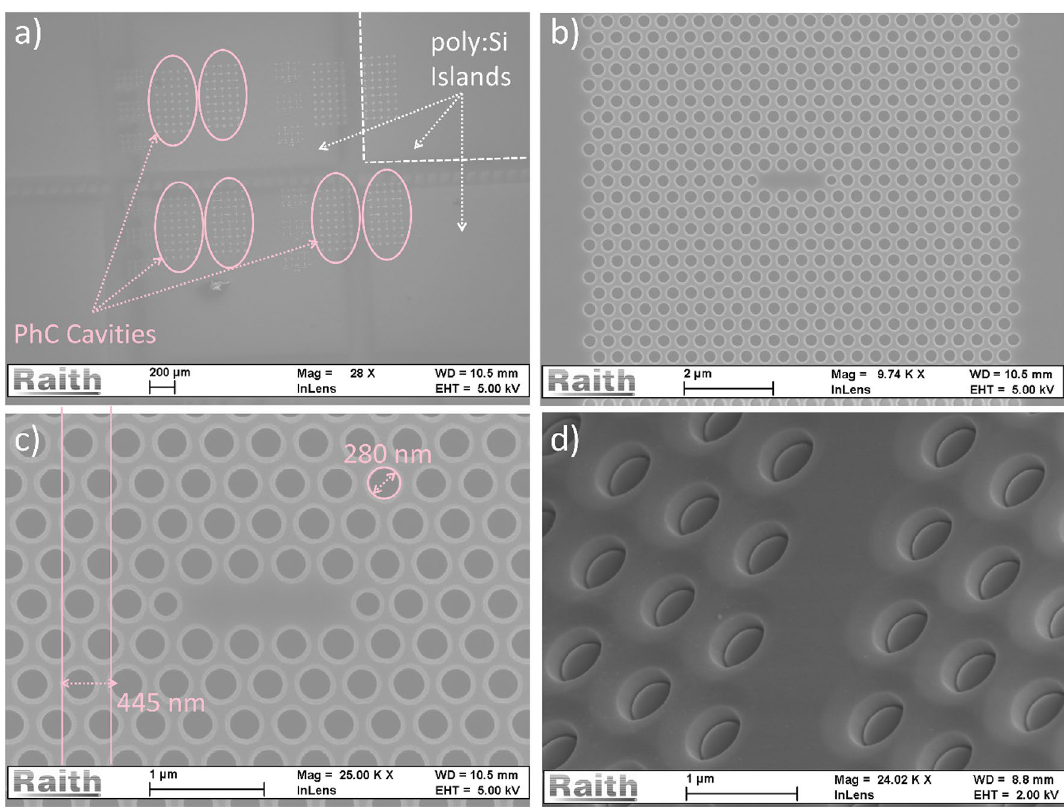
Figure 6. SEM images of the PhC cavities patterned on the deposited poly:Si islands at different magnifications: ( a ) 28x, the PhCs are highlighted by the pink ellipses and dashed arrows and the poly:Si islands are delimited by the white dashed lines, ( b ) Far Field optimized L3 PhC cavity at 9740x, ( c ) same cavity at 25000x, with SEM measurements of hole radius and PhC periodicity and ( d ) PhC cavity imaged at 45°.